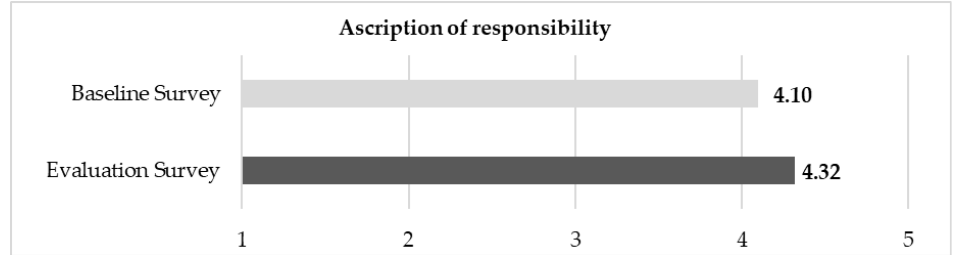
Figure 3. A comparison of ascription of responsibility in Greek public buildings (before and after the trial).